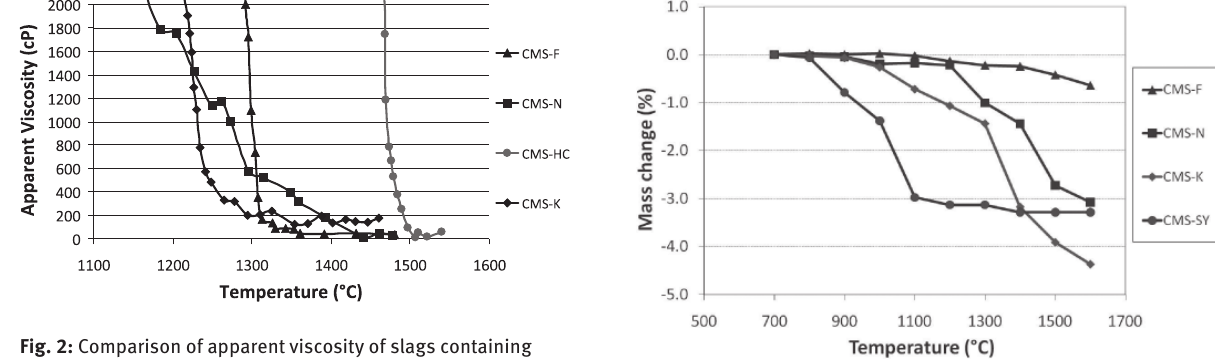
Fig. 3: Mass loss measurements of slags upon heating, normalised to 1873 K ( = 600 °C).